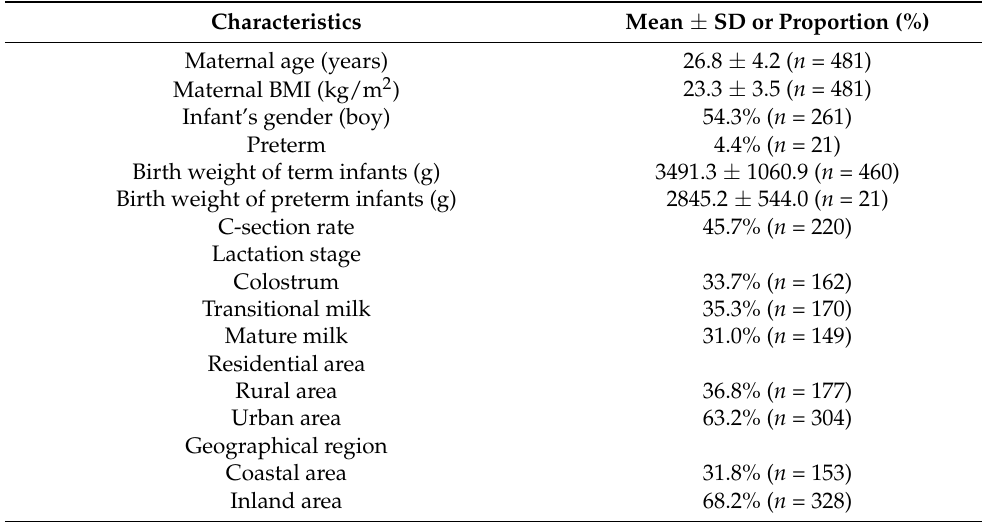
Table 1. Characteristics of the study